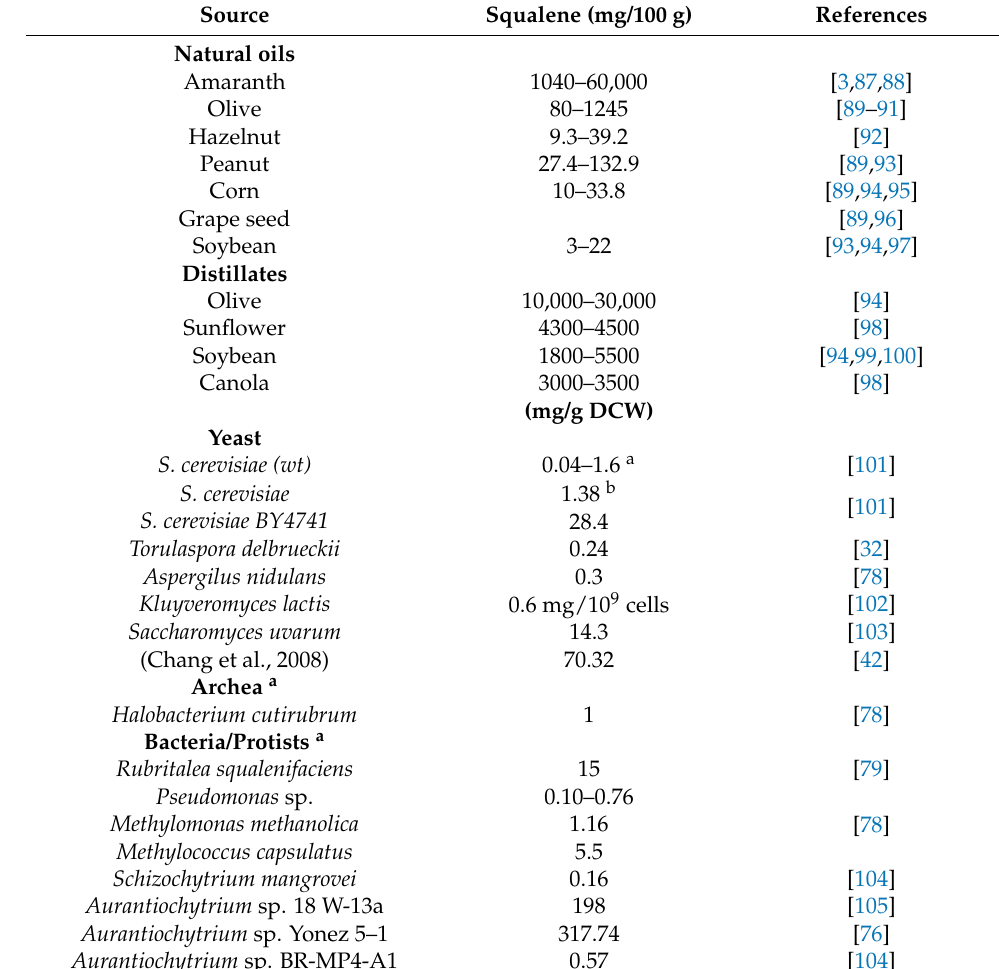
Table 2. Squalene concentration in different natural